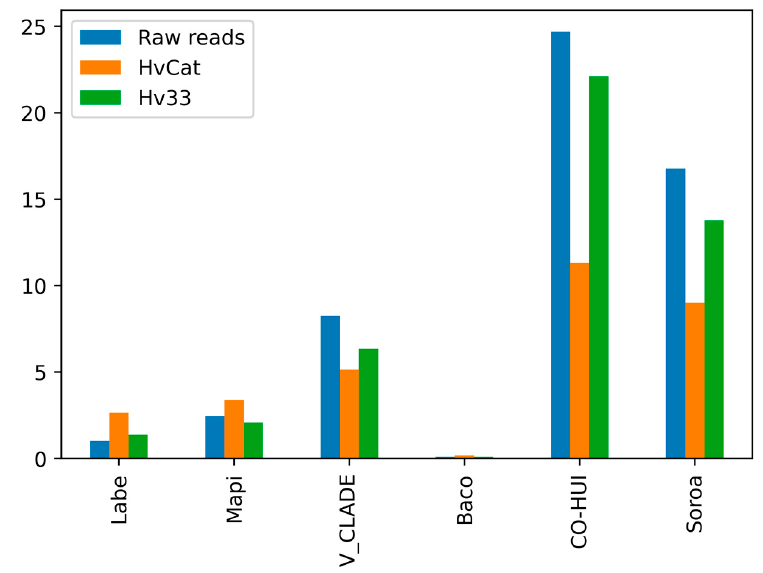
Figure 4. Comparison of the contribution of each LTR-RT lineage to the mapped 454 raw reads (blue), Hv33 assembly (green), and HvCat assembly (orange). The y -axis represents the percentage of genomic information belonging to each lineage.